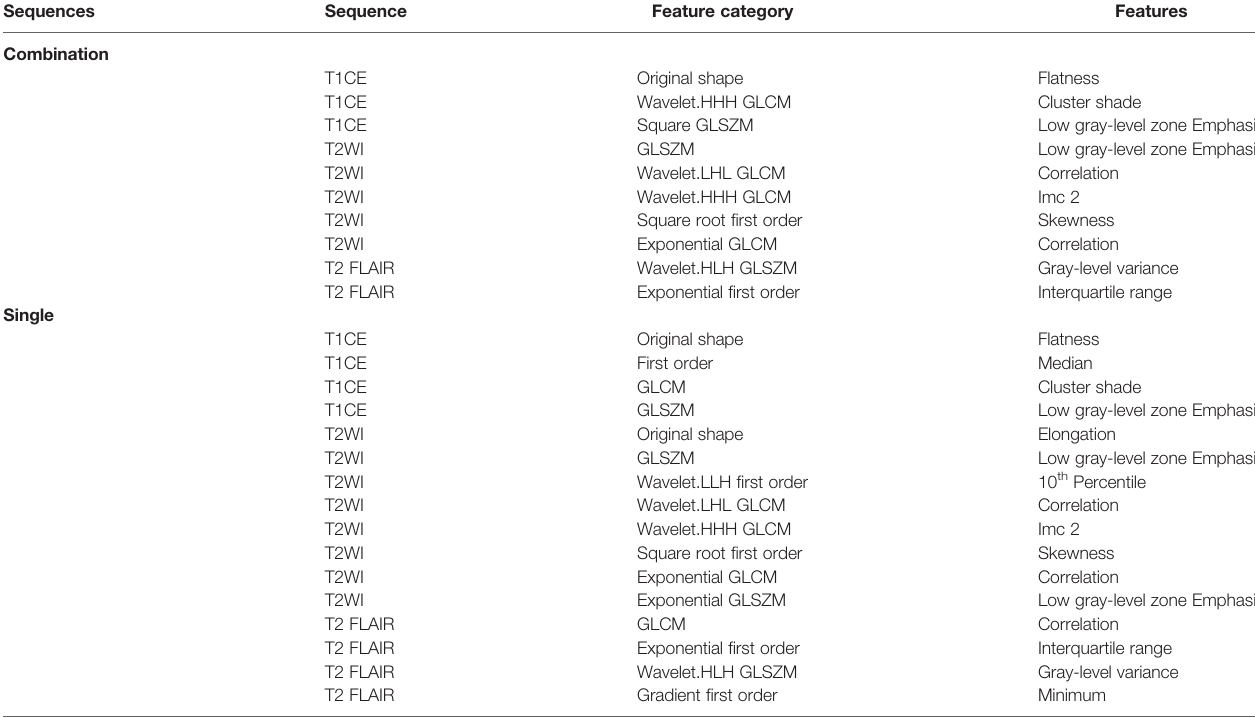
TABLE 2 | Radiomic features used to differentiate EGFR mutation status in various sequences.